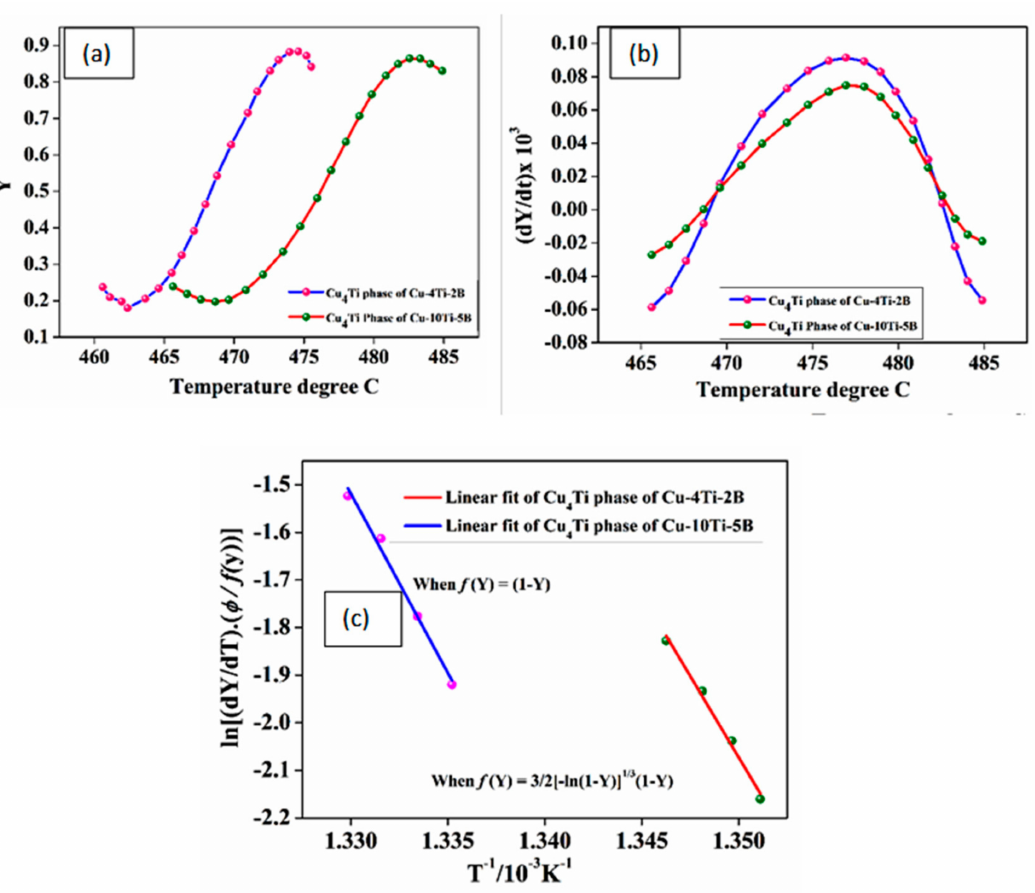
Figure 10. Estimation amount of ( a ) phase fraction with temperature, ( b ) phase rate with temperature, and ( c ) activation energy for two types of alloy composite for Cu4Ti phase